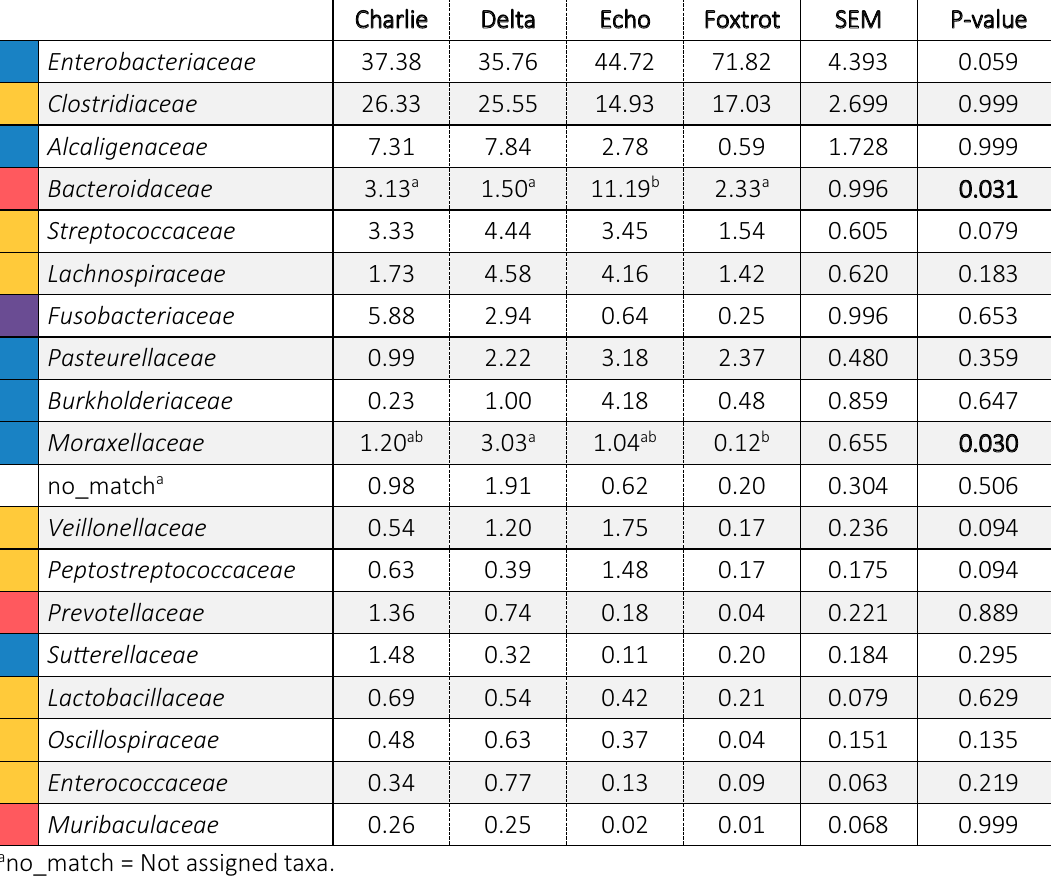
Table 3 Relative abundances (%) of the families present in the faecal microbiota of 2‑day‑old piglets from Trial 2 in a percentage higher than 0.5%, classified by farm and in decreasing order of abundance in relation to the general